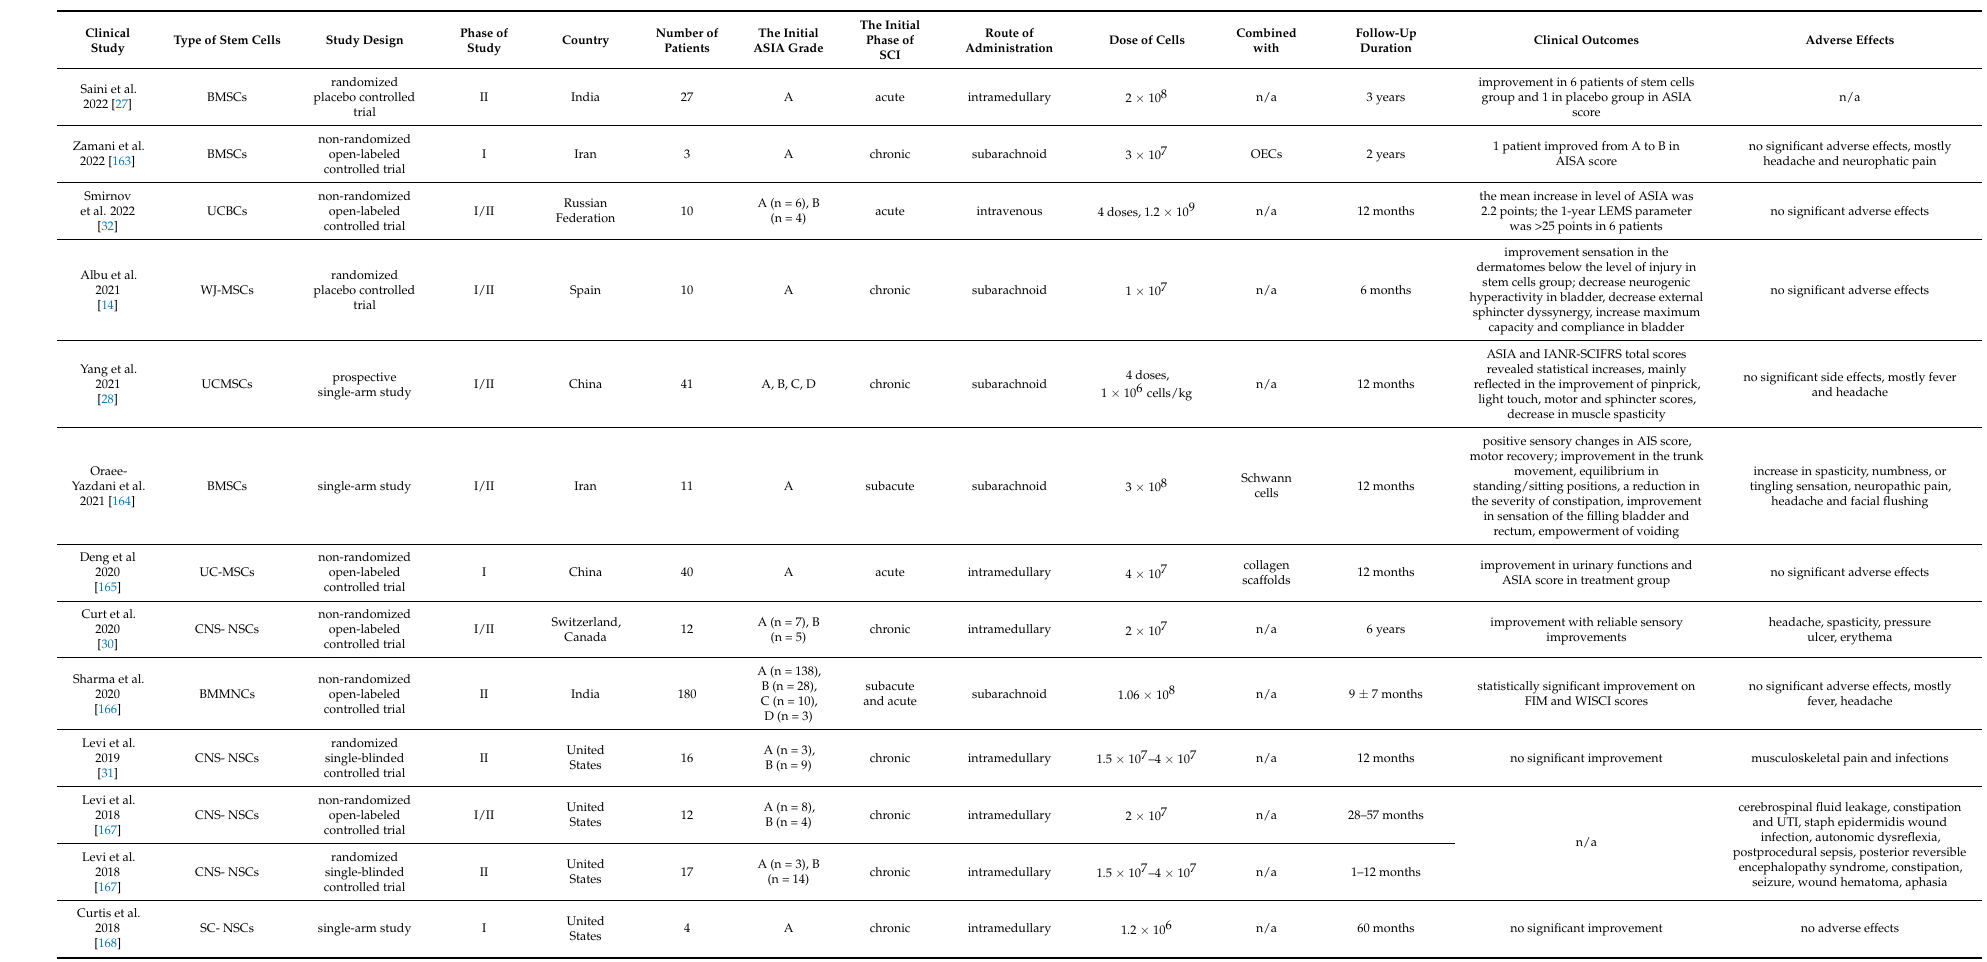
Table 2. Recent clinical studies investigating Stem Cells Therapy for Spinal Cord Injury from the years 2017–2022.